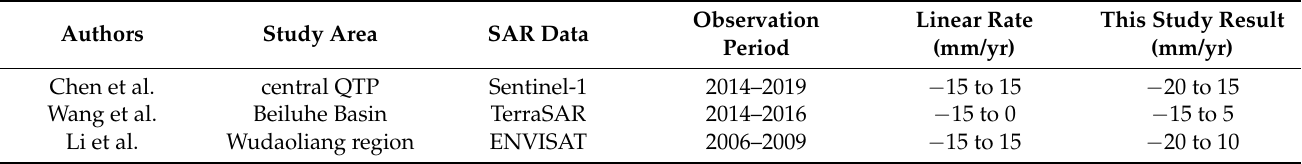
Table 4. Table of comparison between the results of this study and previous